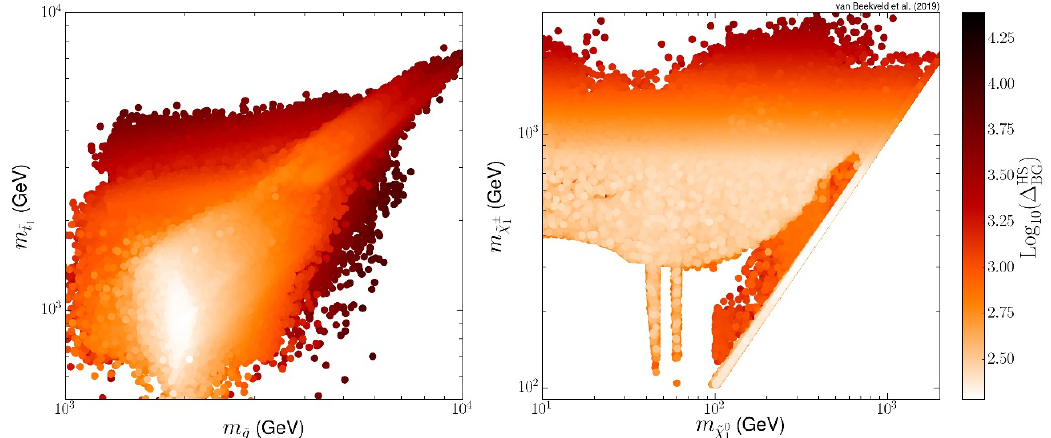
Figure 6 . Left: m ~ g against m ~ m against m DM for the allowed spectra. The masses are given in units of GeV. The color code ~ (cid:31) (cid:6) 1 indicates the value for log with higher values.